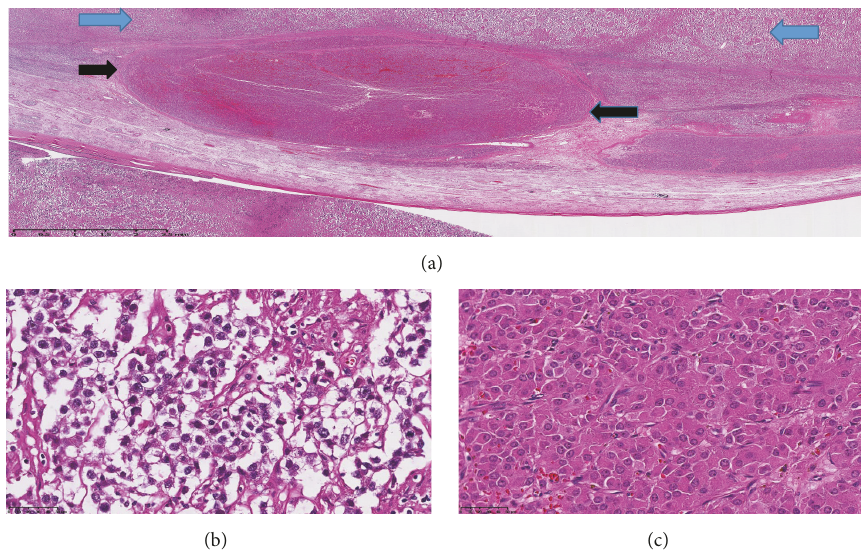
Figure 1: Histological examination of the left-sided testicular mass.Two distinct massesare identified. (a) Theclassic seminoma with clear cell morphology (depicted by the blue arrows) is on the top and the circumscribed Leydig cell tumor is at the bottom (black arrows) (hematoxylin and eosin (H&E), × 250). On higher magnification, (b) the seminoma cells contain abundant clear cytoplasm and slightly hyperchromatic nuclei (H&E, × 4000). (c) The Leydig cell tumor is composed of polygonal cells with prominent nucleoli with eosinophilic, granular, and vacuolated cytoplasm (H&E, × 4000).